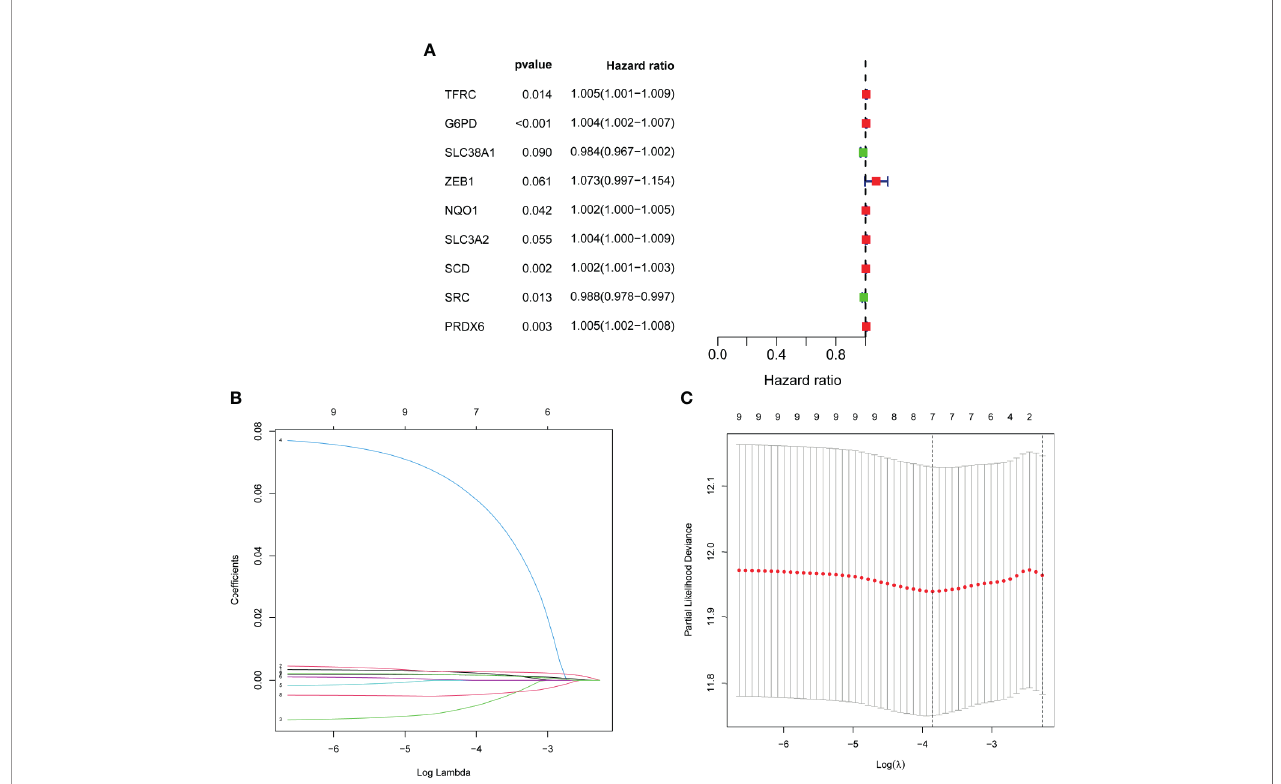
FIGURE 3 | Development of FRG prognostic signature in TCGA cohort. (A) Results of the univariate cox analysis of the OS in TCGA-BLCA cohort. (B) Ten-time cross-validation for tuning parameter selection in the LASSO Cox regression model. (C) LASSO coef fi cient pro fi les of the seven ferroptosis-related genes. FRG, ferroptosis − related gene; TCGA, The Cancer Genome Atlas; BLCA, bladder cancer; LASSO, least absolute shrinkage and selection operator.